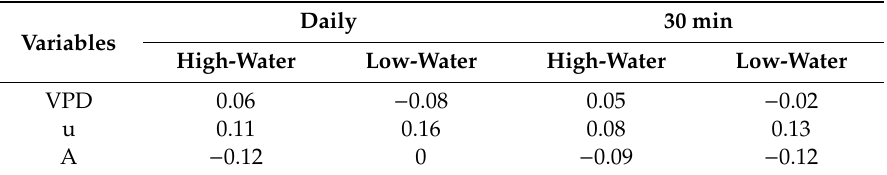
Table 4. Magnitudes of contributions of VPD and u to α